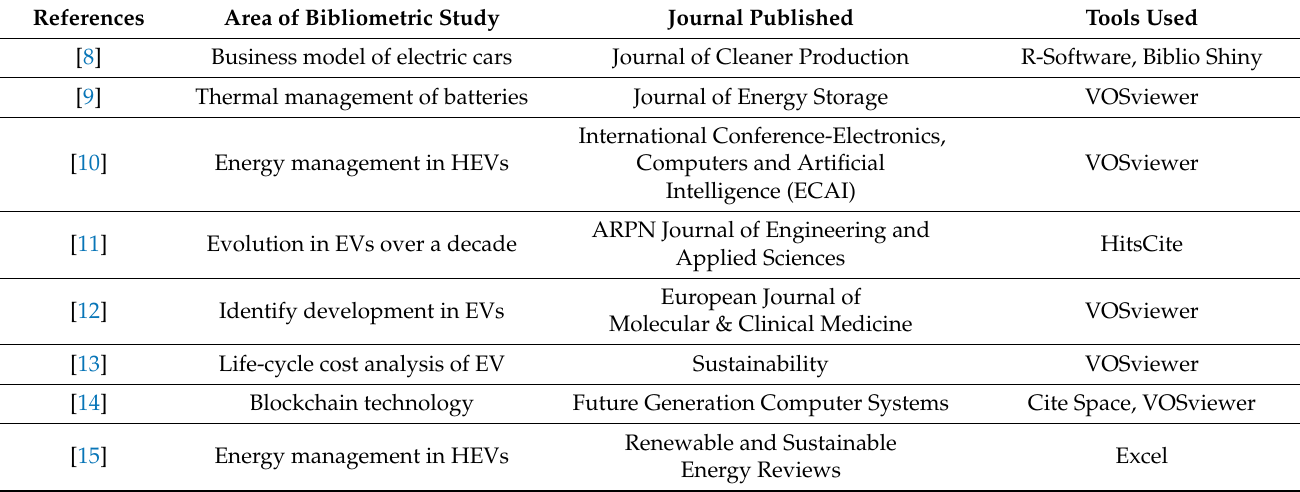
Table 1. List of study related to the Bibliometric method and EV.